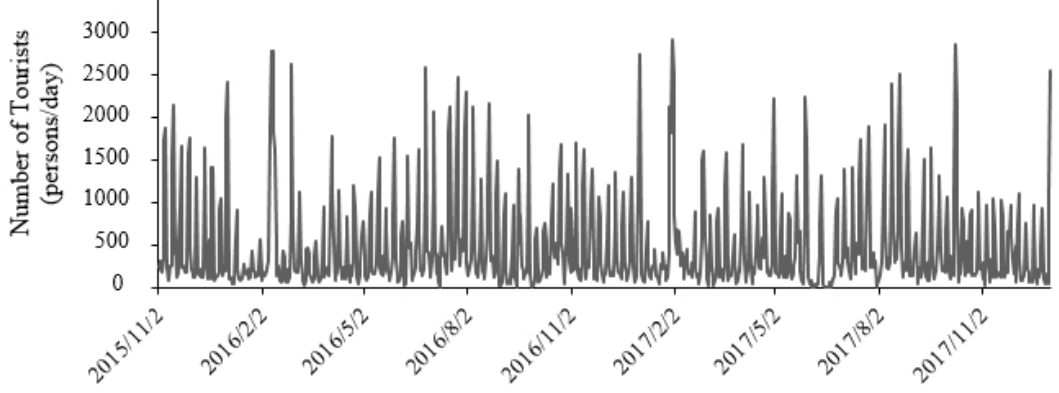
Figure 4. Huisun Forest Park 11/2/2015–12/31/2017 number of tourists data.